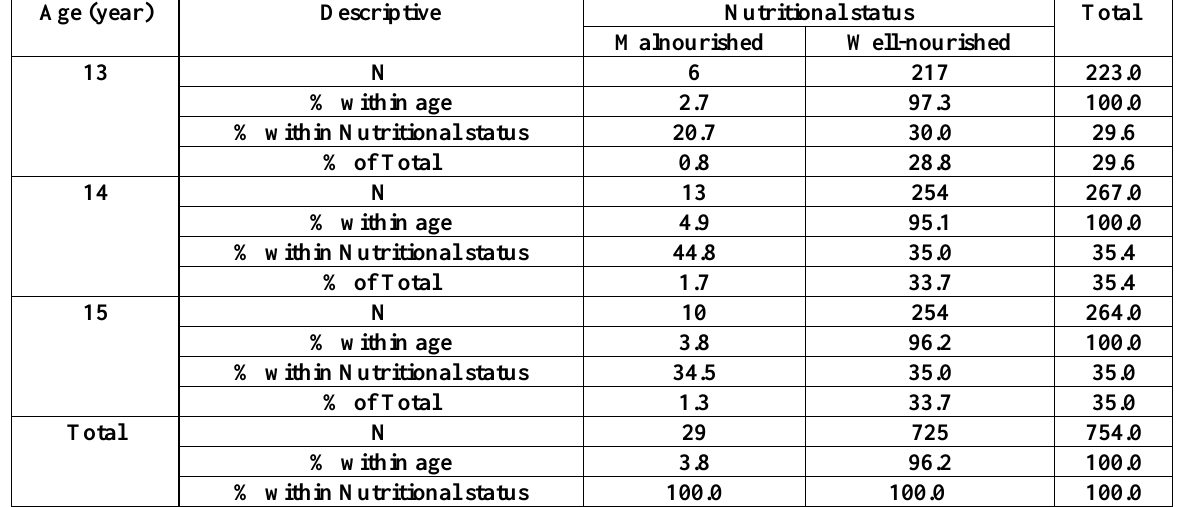
Table 2: Distribution of the students according to the nutritional status by age groups.